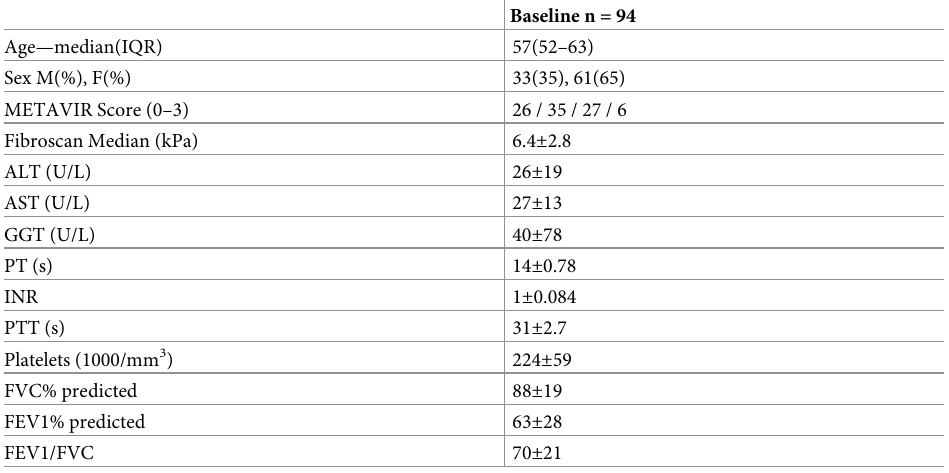
Table 1. Selected baseline characteristics of the study population.